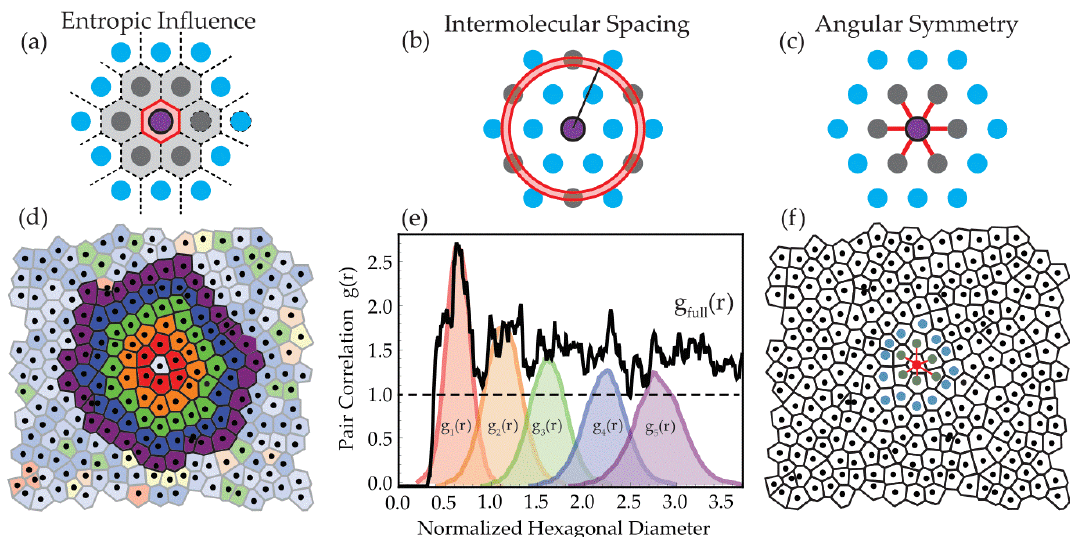
Figure 4. Schematic of order metrics used to characterize the morphology located at particle positions: ( a ) Voronoi tessellations ( b ) pair correlation function ( c ) bond order parameter, for each category of order possible in a 2D pattern. ( d ) Voronoi tessellation of a planar pattern of particles with coloring scheme representing the Voronoi shell description of neighbors. The coloring scheme of outlier cells reflects the deviation of covering area from that of a hexagonal lattice. ( e ) The pair correlation function separated by the Voronoi shells, showing the connection between local and global order metrics. The sum of finite shellular descriptions leads to an approximation of the configurational average g(r). At large values, the value of the pair correlation goes to uniform probability (a value of 1 shown by the dotted horizontal line). ( f ) Voronoi tessellation of a planar pattern of particles showing the “bonds” connecting adjacent particles, where the angle between bonds compared against the expected angle for hexagonal packing can be used to determine the local bond order for each cell, as well as the ensemble average global bond order.